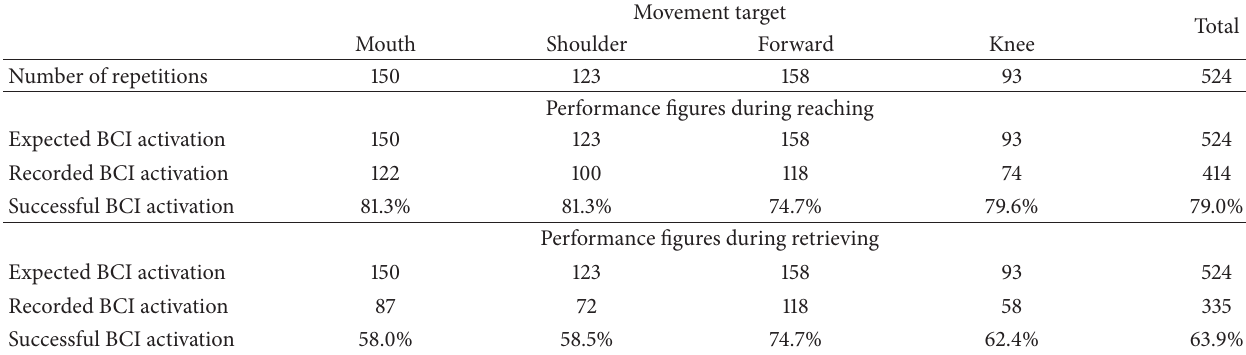
Table 2: Performance for movements with two phases (reach and retrieve).